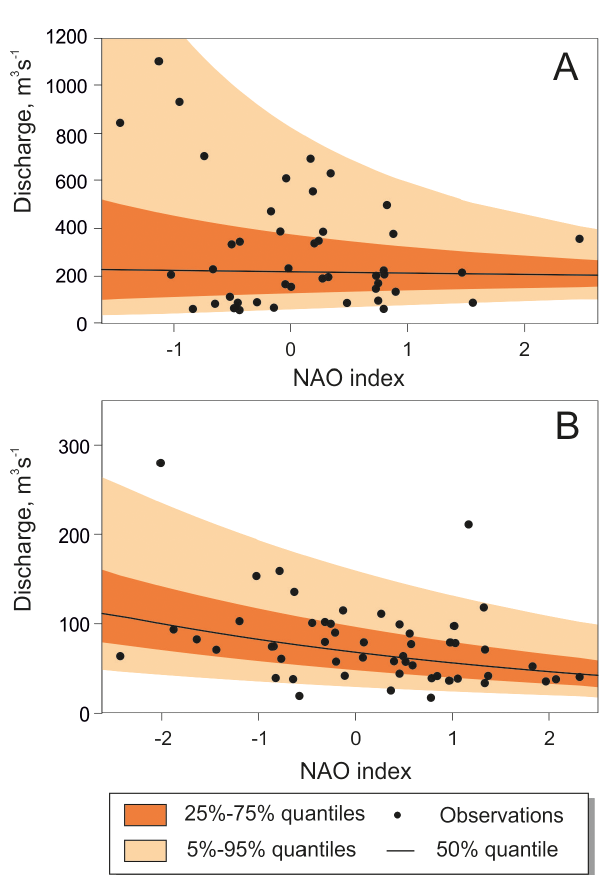
Figure 8. Estimated quantiles for the model with the NAO index as the explanatory variable plotted against NAO index. (a) Plot for the Aranjuez gauge in the period 1913–1956; (b) plot of the period